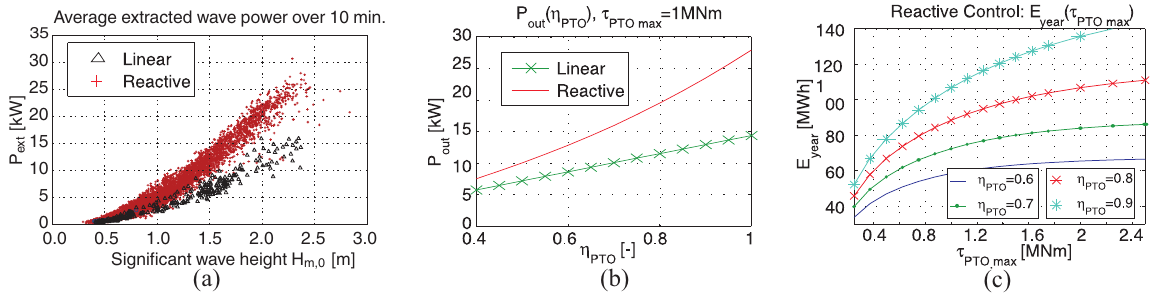
Figure 21. ( a ) average extracted power measurements for a single absorber of the prototype in Figure 5a [22]. Each point is a 10 min measurement; ( b ) comparison of power extraction of linear damping and reaction as a function of efficiency in a sea state with H and T = 4 . 5 s [11]; and ( c ), yearly production of a single absorber at the prototype site [28] p as a function of PTO torque limitation and efficiency